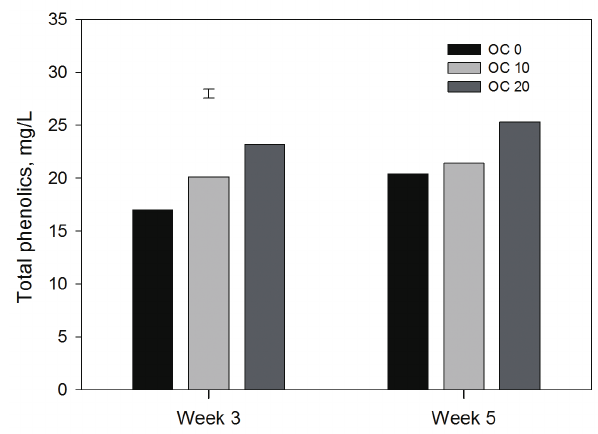
Figure 1. Total phenolic content of goat milk fed different dietary level of olive cake silage (OCS) (OC, control; OC10, 100 g/kg dry matter OCS; OC20, 200 g/kg dry matter OCS; standard error of the mean = 0.82; n = 18, p<0.001 for dietary level of OCS, p<0.01 for